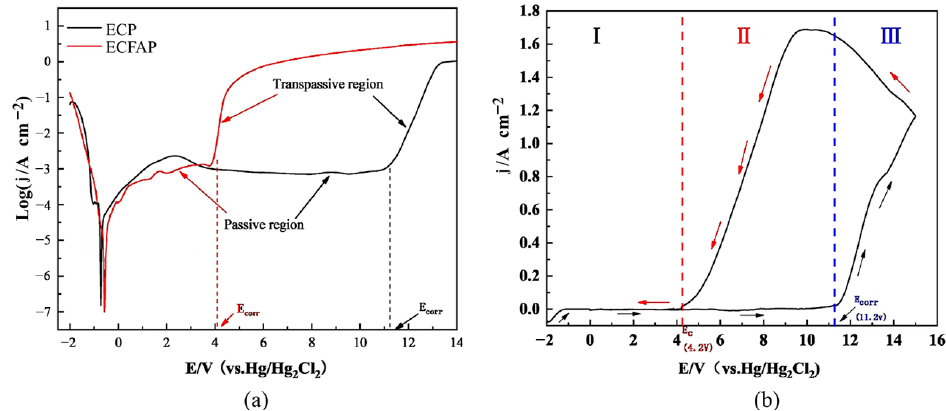
Figure 4. Polarization and cyclic voltammetry (CV) curves of TC4. ( a ) polarization curves under ECP and ECFAP conditions; ( b ) CV curve under ECP conditions.